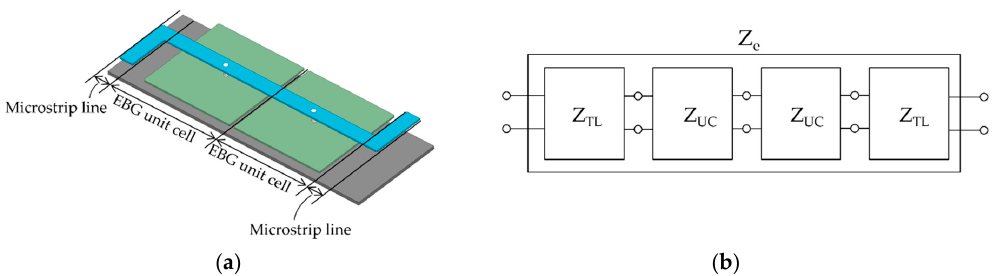
Figure 3 . ( a ) Decomposition of DGS–EBG structure into microstrip lines and EBG unit cells; ( b ) their impedance diagram.